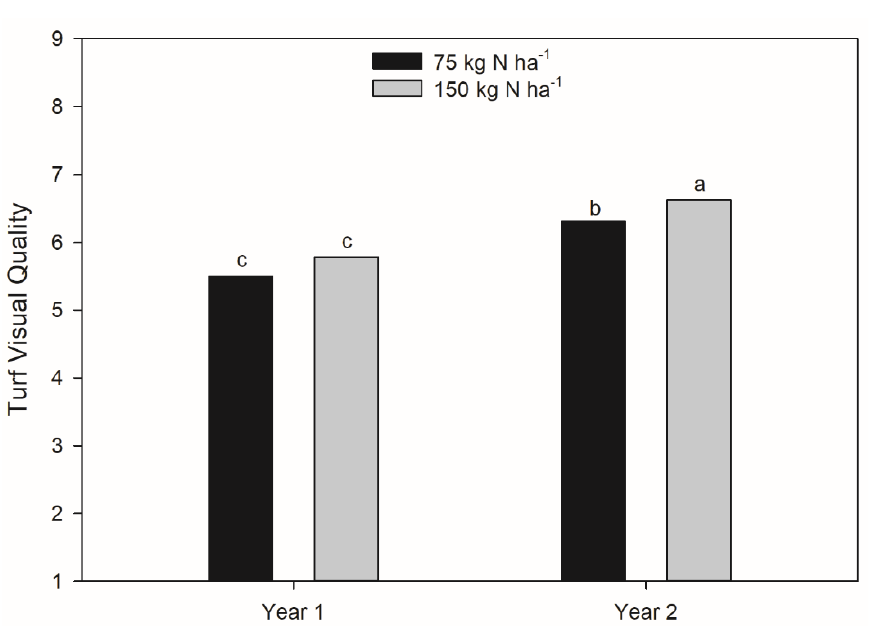
Figure 2. Turfgrass quality as affected by year. Data are averaged over 2 N rates, 12 months, and 3 replicates, and represent an average of 72 data points. Turfgrass quality was visually assessed (1−9 scale). Mean values with the same letters are not significantly different from one other (Fisher’s protected LSD test at the 0.05 probability level).